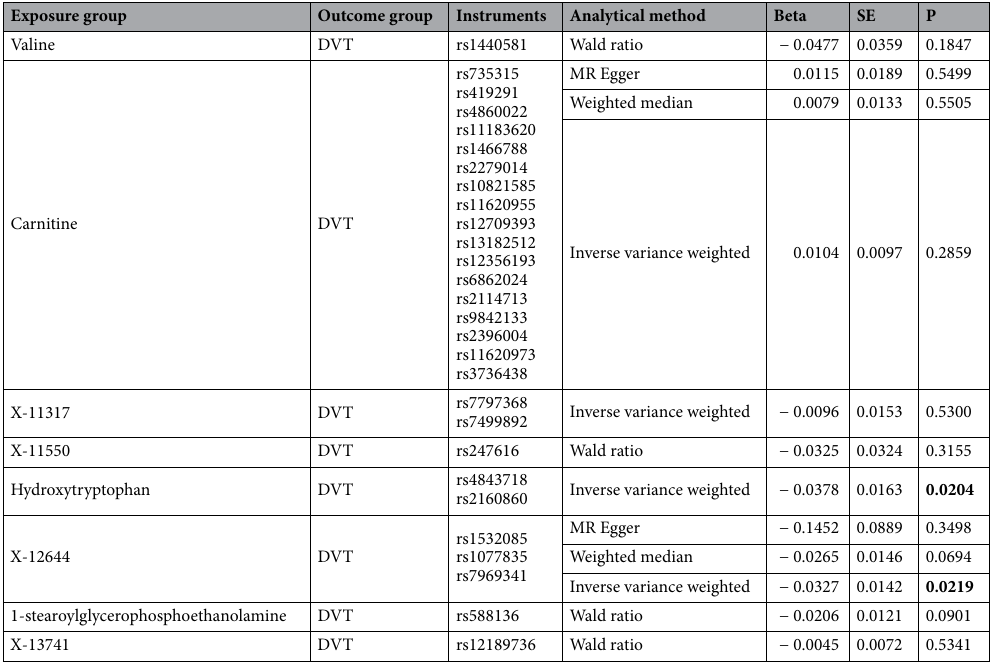
Table 2. The results of causal analysis of human blood metabolites (exposure) and deep vein thrombosis (outcome). Since no SNP in X-12465 can perform causal analysis, it is not listed. DVT: deep vein thrombosis. Significant values are in